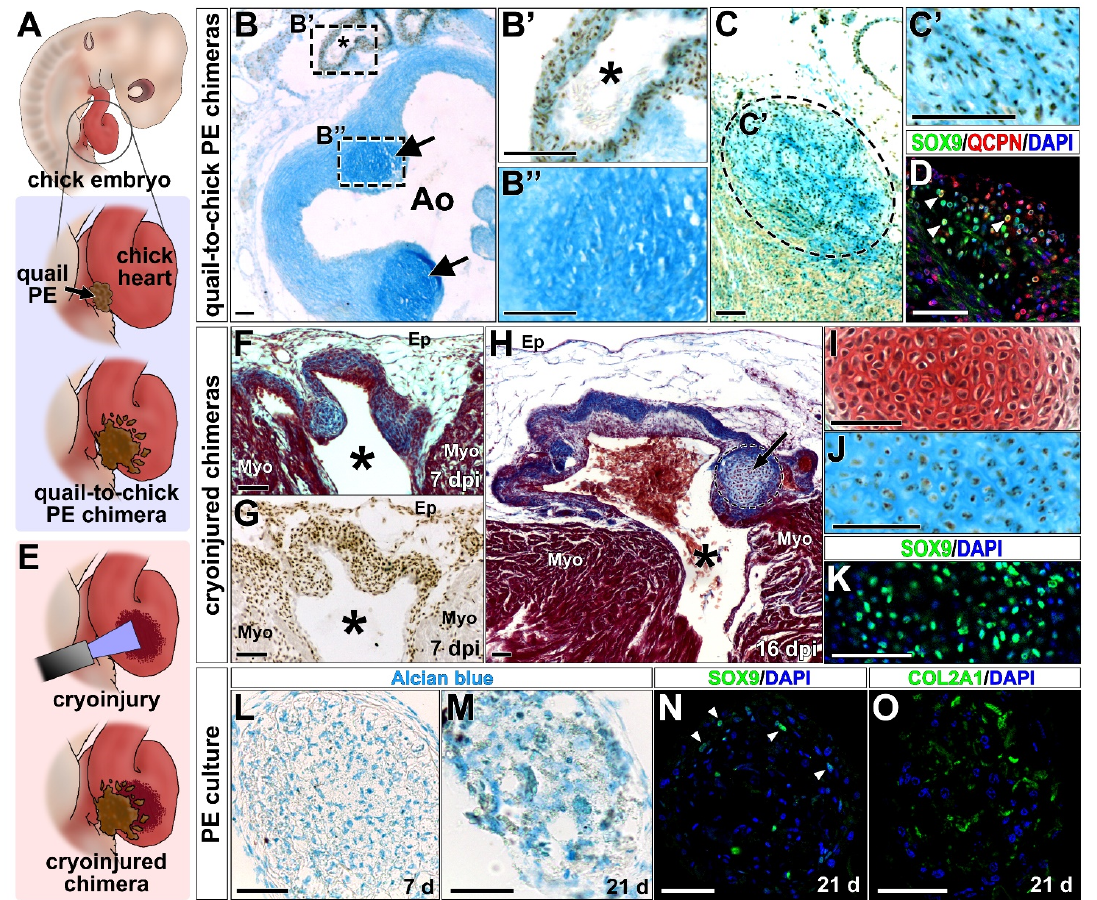
Figure 2. The proepicardium is a source for chondrocytes in the developing heart. ( A ) Quail-to-chick proepicardial chimeras were used to dissect the proepicardial contribution for chondrocytes in